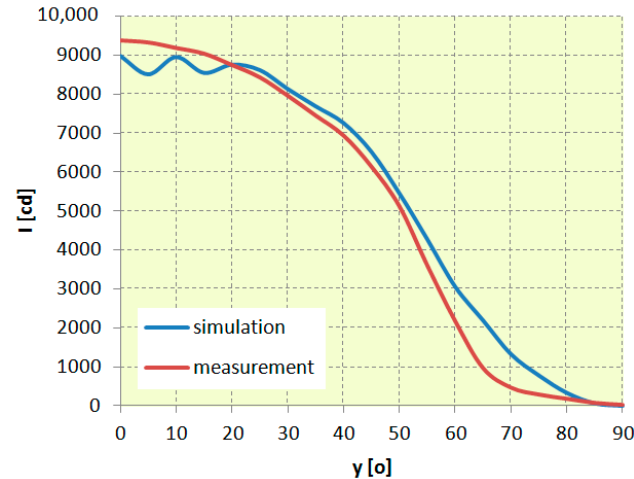
Figure 21. The comparison of luminous intensity curves of a light-optical system for medium wide distribution obtained as a result of simulation and prototype measurements.